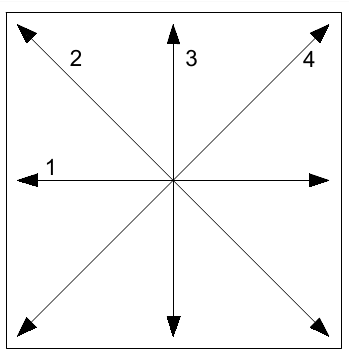
Figure 6. Directions of the resistivity measurement.